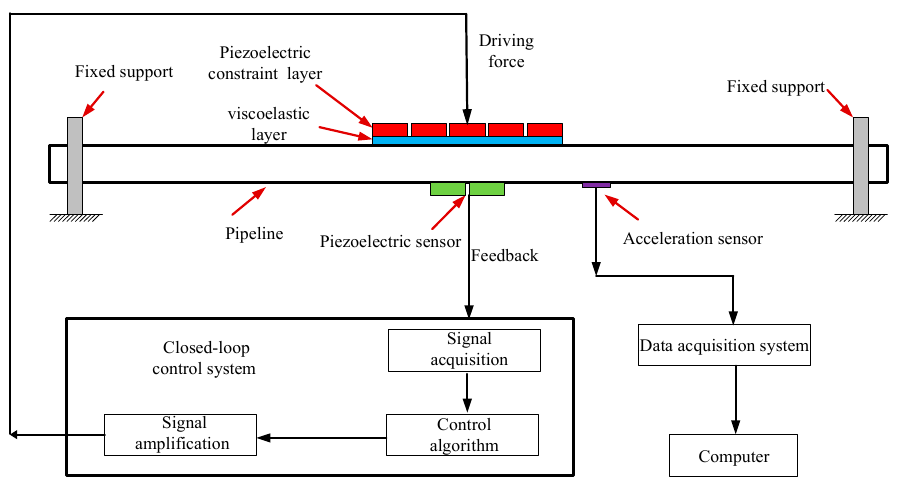
Figure 9. Schematic diagram of vibration control platform for pipeline with ACLD patches.